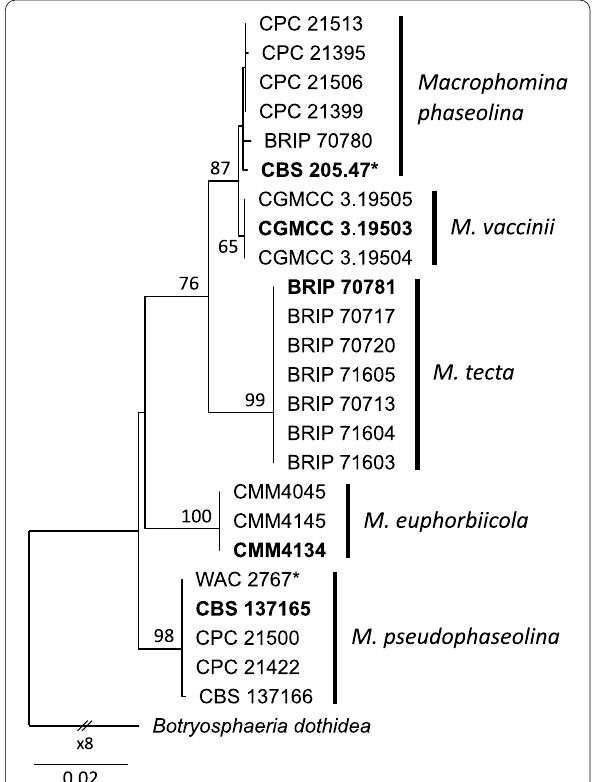
Fig. 5 Maximum Likelihood phylogram of Macrophomina species inferred from the concatenated alignment of the internal transcribed spacer sequences of the nuclear ribosomal DNA and the intervening 5.8S region (ITS), actin, calmodulin, translation elongation factor one-alpha, and beta tubulin sequences obtained from Poudel et al. (2021) and Sarr et al. (2014). Alignment and tree were submitted to TreeBase (No. 28996). The tree was constructed using RAxML v.8 (Stamatakis 2014), based on the GTR substitution model with gamma-distribution rate variation for individual partitions. The tip labels in bold represent ex-type strains, and asterisks denote strains sequenced in the current study. Bootstrap support values > 80% are shown at the branches. The tree is rooted to Botryosphaeria dothidea (Poudel et al. 2021). The scale bar represents nucleotide substitutions per